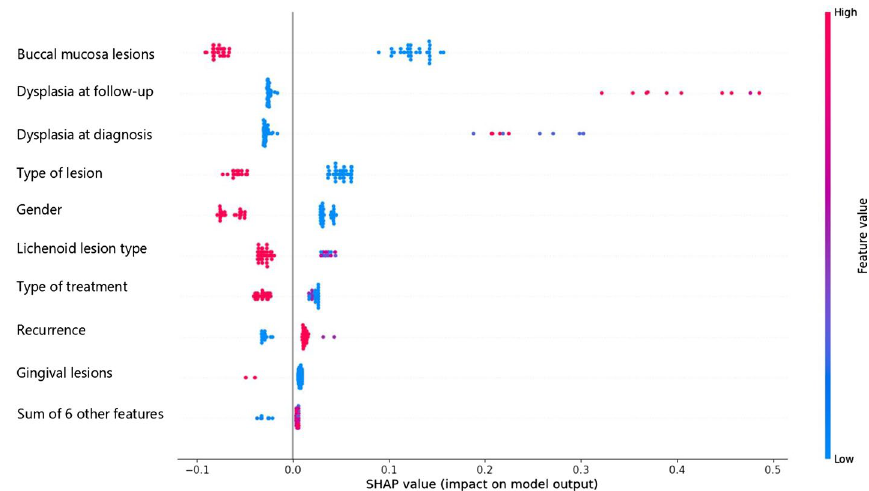
Fig. 5 Global SHAP summary plot to explain the importance of the features to the model predictions of the gradient boosting‑ADASYN model (with 15 input parameters)